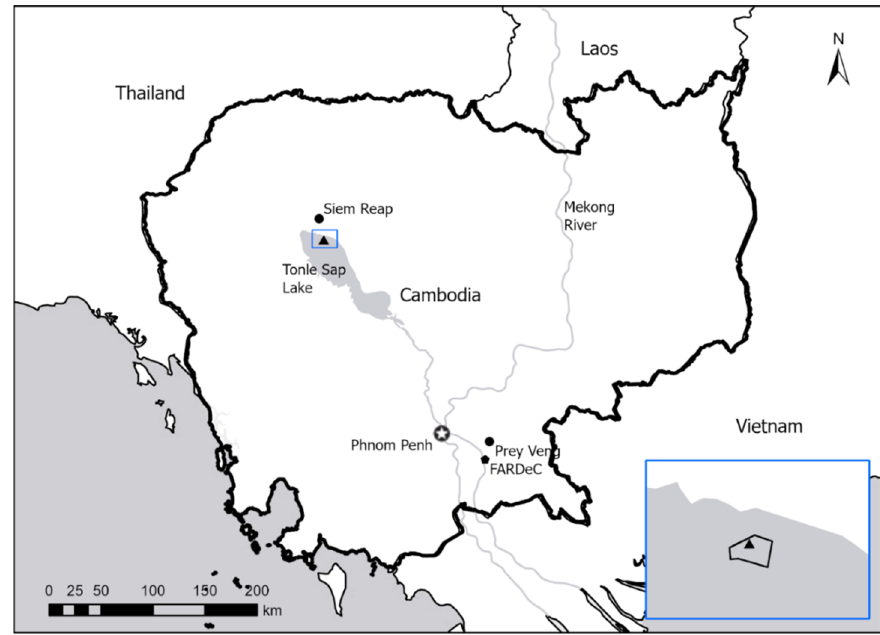
Figure 1. Map showing the location of the fish release (black triangle) within the Tonle Sap Lake, Cambodia. The black pentagon denotes the Freshwater Aquaculture Research and Development Center (FARDeC). The black polygon shown in the inset map delineates the boundary of the fish reserve in former fishing lot